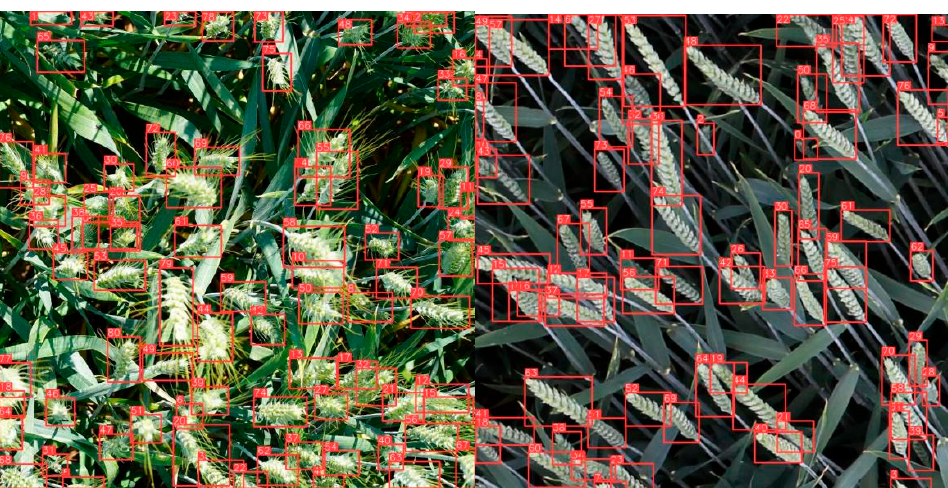
Table 4. The results of wheat ear detection based on different methods.